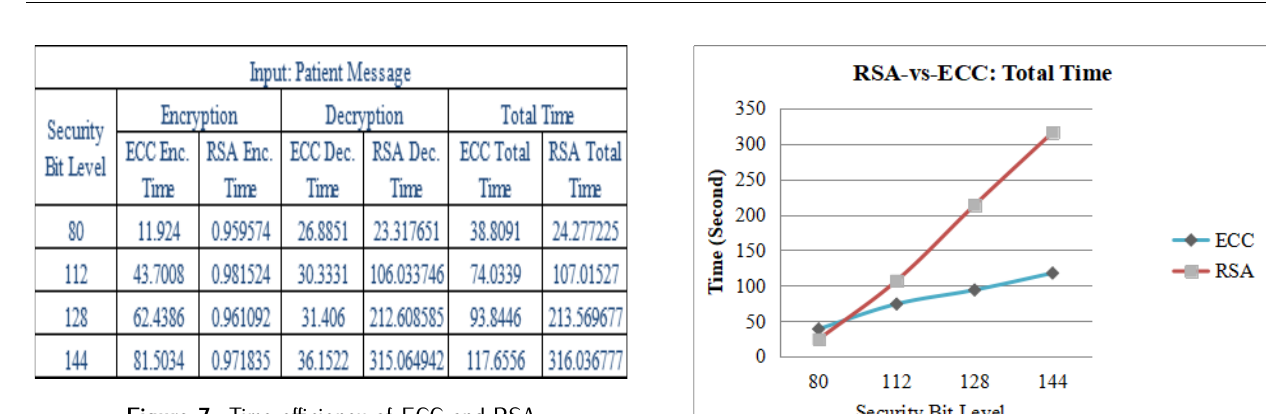
Figure 7. Time efficiency of ECC and RSA